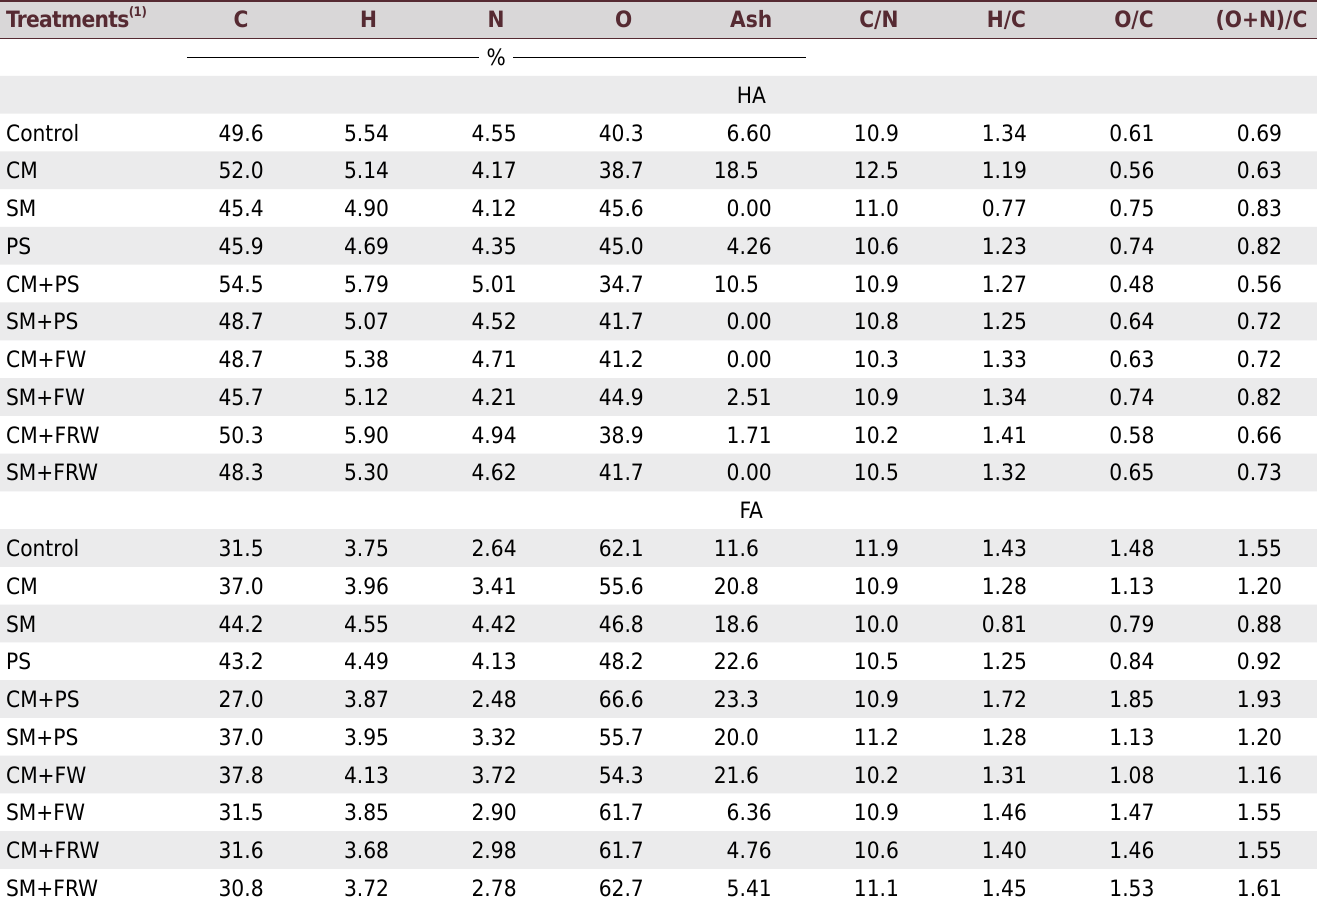
Table 5. Elemental composition (C, H, N, O), ash content (Ash), C/N ratio, H/C, and O/C atomic ratios and polarity index [(O+N)/C] of humic acids (HA) and fulvic acids (>1 kDa) (FA) of an Acrisol amended with vermicomposts and incubated for 182 days Treatments (1)